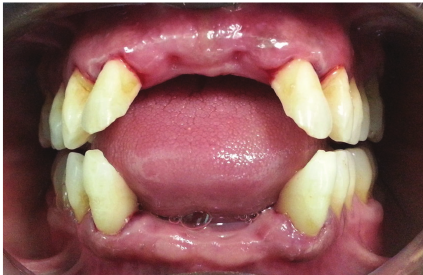
Figure1:Patientpresentingwithlossandflaringofteethandtongue occupying the space.